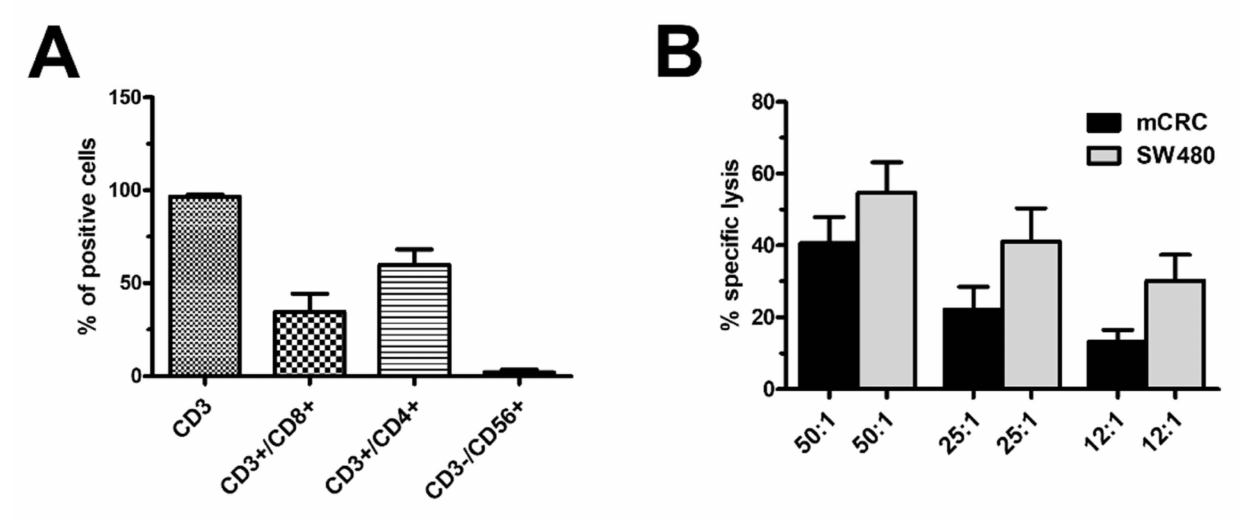
Figure 1. Characteristics of expanded TILs. Immunophenotype and potency were evaluated in TIL derived from 10 patients after 14 days’ expansion. ( A ) Analysis of surface antigen expression. Results are expressed as the mean and SD % receptor surface expression of CD3+, CD3+/CD4+, CD3+/CD8+ and CD3 − /CD56+ cell populations. ( B ) Cytotoxic activity of TILs was tested in a 5-h cytotoxicity assay against the autologous mCRC cells (black column) and SW480 cell lines (grey column) at various E:T ratios ranging from 50:1 to 12:1. Means and SD of percentages of specific lysis are